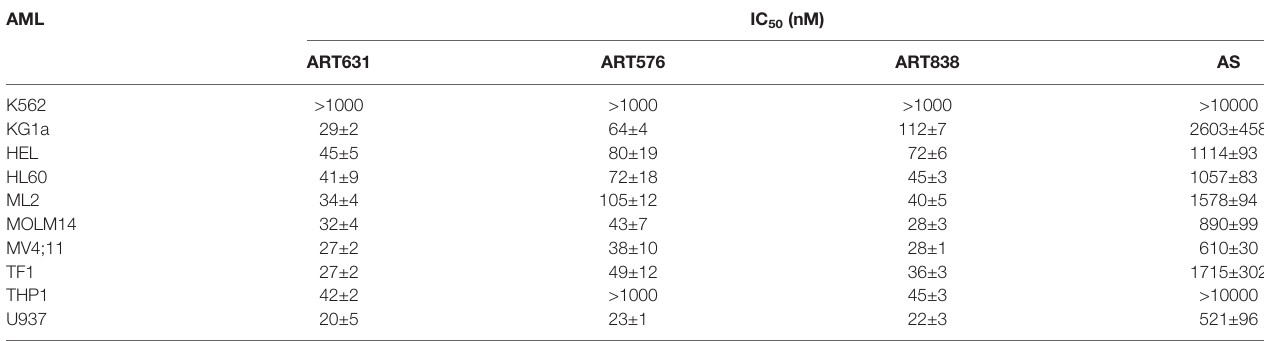
TABLE 2 | In vitro IC 50 values for ART analogs against 10 human AML cell